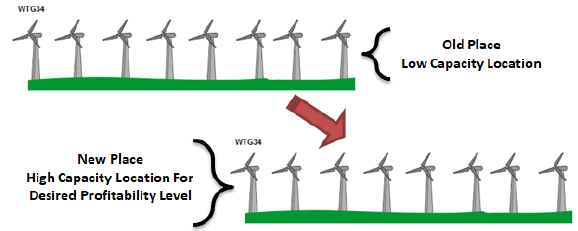
Figure 1. Relocation of wind